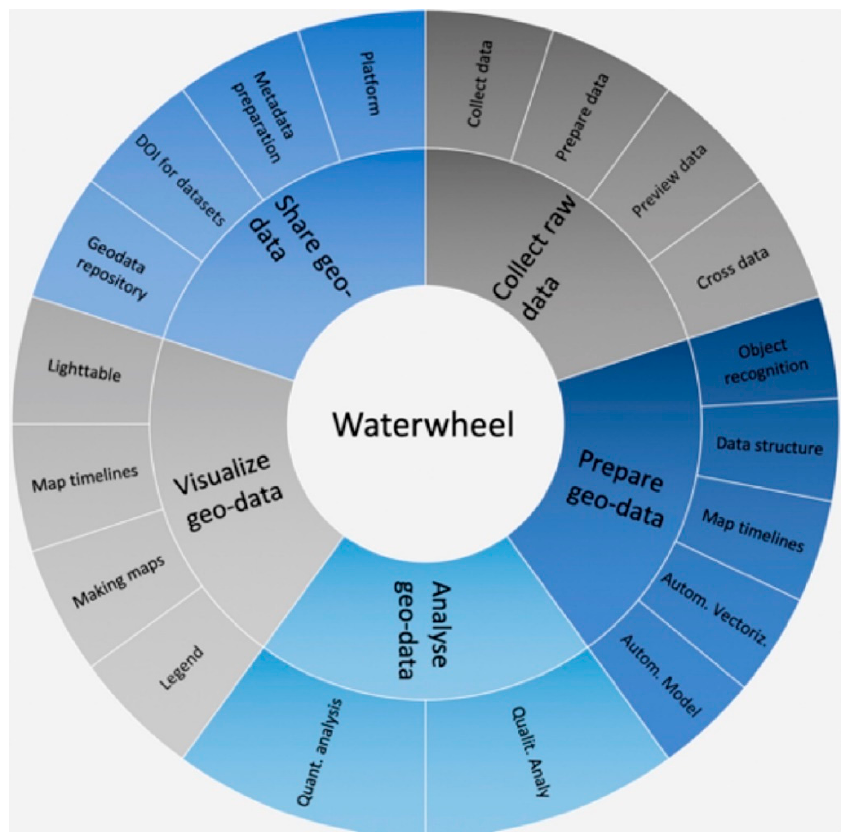
Figure 1. The WaterWheel symbolizes the life cycle of information and data in a digital humanities project [7].